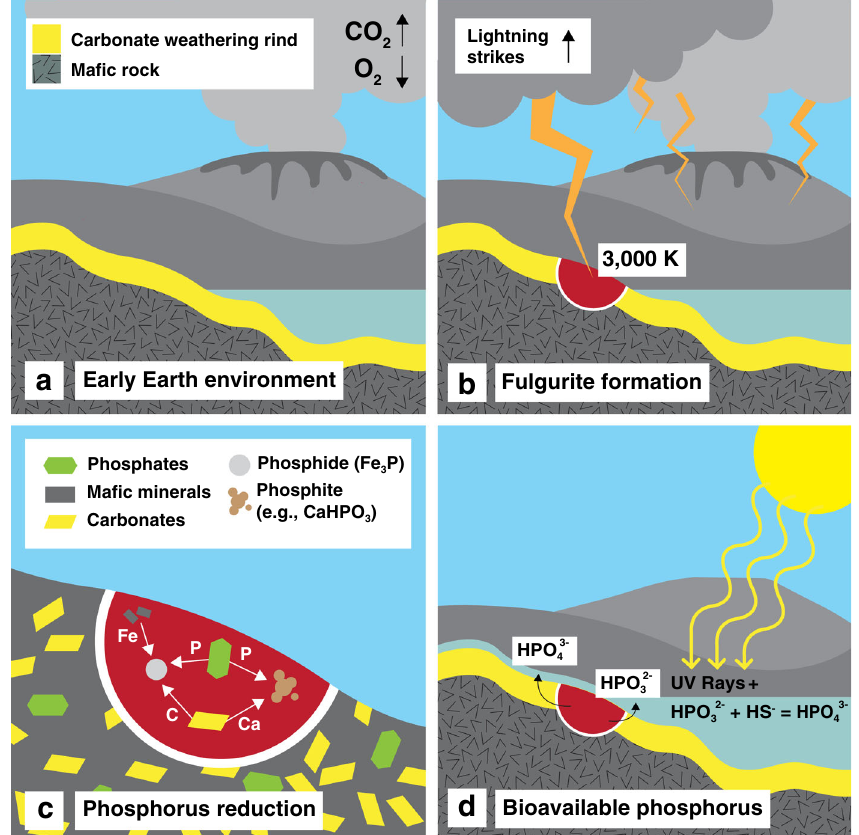
Fig. 4 Phosphorus reduction by lightning on early Earth. a Anoxic and H 2 O- and CO 2 -rich atmosphere reacts with abundant crustal ma fi c rocks to form carbonate weathering rinds on the ma fi c rock. b Early Earth had higher lightning rates because of higher pCO 2 33,44 . When lightning strikes rock, melting occurs, creating a fulgurite (shown in dark red). c Within the fulgurite, iron, phosphorus, and carbon sourced from ma fi c minerals, phosphates such as apatites, and carbonates, respectively, allow for the formation of reduced phosphides such as Fe 3 P and intermediate phosphites such as CaHPO 3 . d Surface water dissolves phosphides and phosphites, which accumulate as hydrous phosphite, hypophosphite, and phosphate species in terrestrial environments. Intermediate phosphorus species react with UV rays and volcanically sourced HS − to form additional phosphates available for prebiotic chemistry 11 fl ux scenarios 17 (Fig. 5c) and then by using the rationale and numbers shown in Fig. 5b.